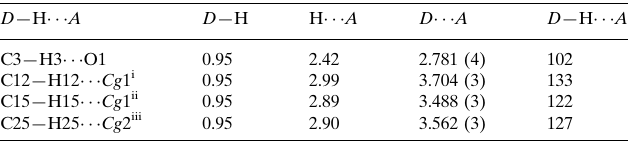
Hydrogen-bond geometry (A˚ , (cid:1)